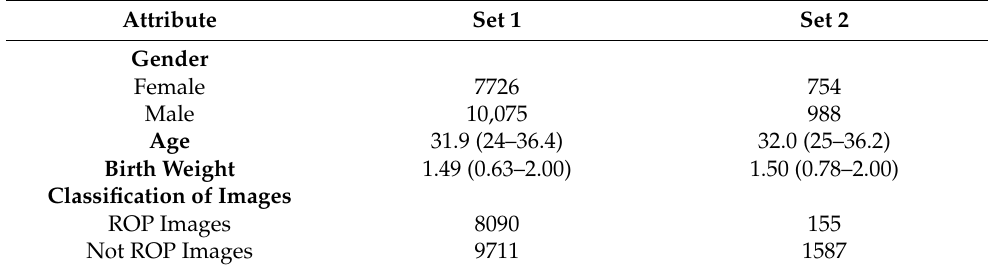
Table 1. Characteristics of the subjects.